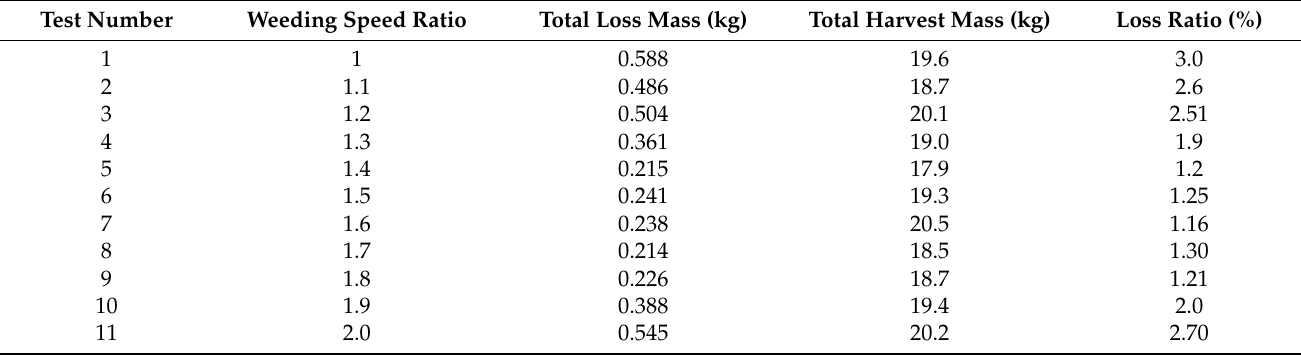
Table 1. Table of rice loss